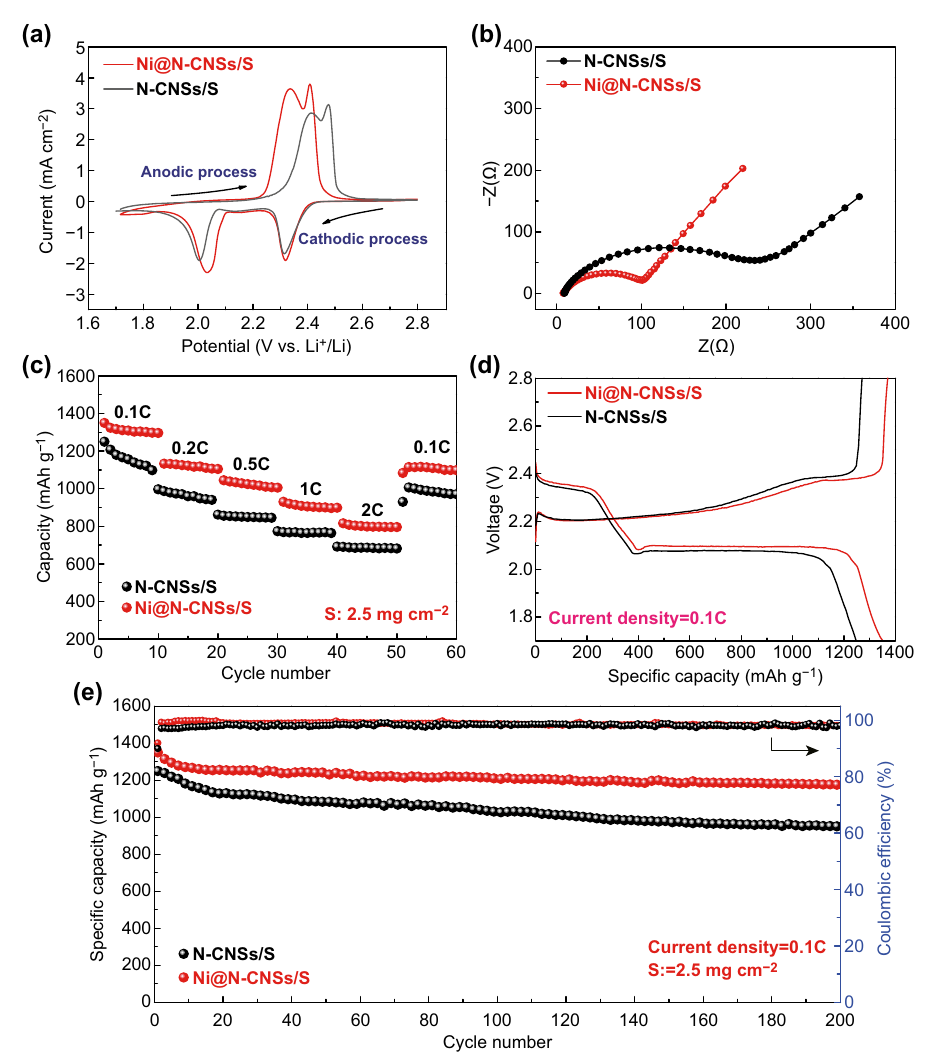
Fig. 6 Electrochemical characterization of N-CNSs/S and Ni@N-CNSs/S electrodes. a CV curves at a scan rate of 0.1 mV s −1 at the second cycle. b Nyquist plots. c Rate capability with a sulfur loading of 2.5 mg cm −2 . d Discharge/charge profiles at 0.1 C. e Cycling performance and coulombic efficiency at 0.1